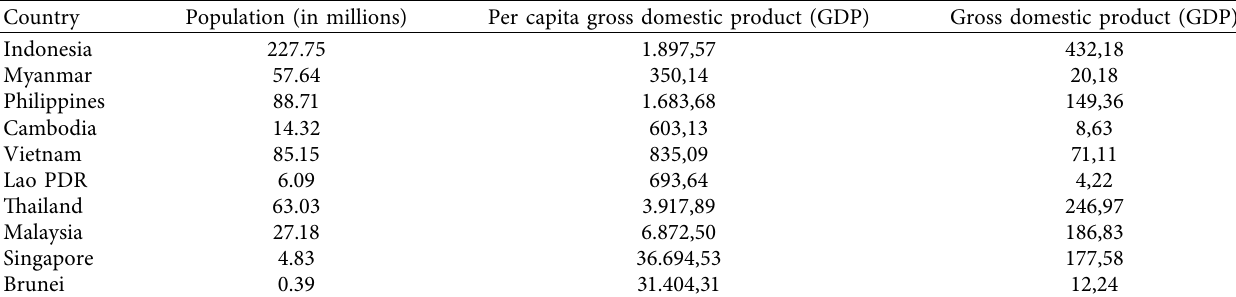
Table 2: Key economic characteristics of ASEAN countries